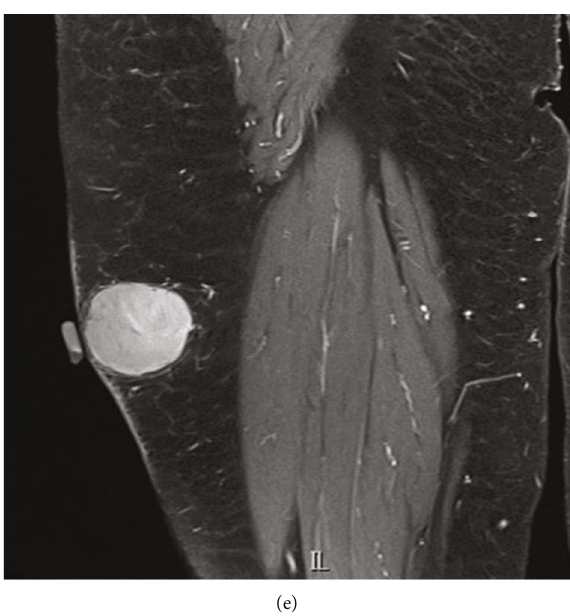
Figure 1: MRI (a) axial T1 WI nonfat saturated demonstrates mild hyperintensity compared to skeletal muscles. (b) Axial T2 WI with fat saturation demonstrates marked homogenous hyperintensity. (c) Axial subtraction image (pre- and post-IV gadolinium contrast) T1 WI with fat saturation con fi rms the homogeneous avid enhancement. (d) Axial T1 WI with fat saturation, precontrast demonstrates mild hyperintensity compared to skeletal muscles. No fat signal suppression. (e) Coronal T1 WI with fat saturation, post-IV gadolinium contrast injection demonstrates homogeneous avid